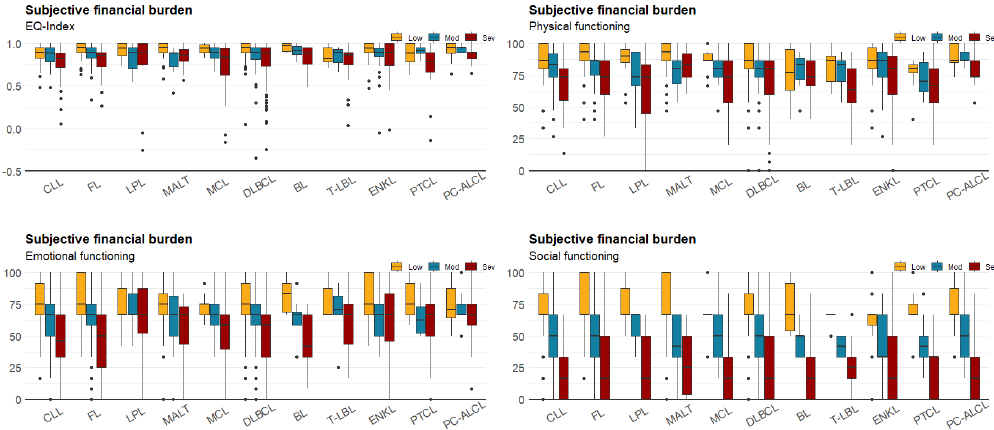
Figure 3. Boxplot for patients’ HRQoL and subjective financial burden.